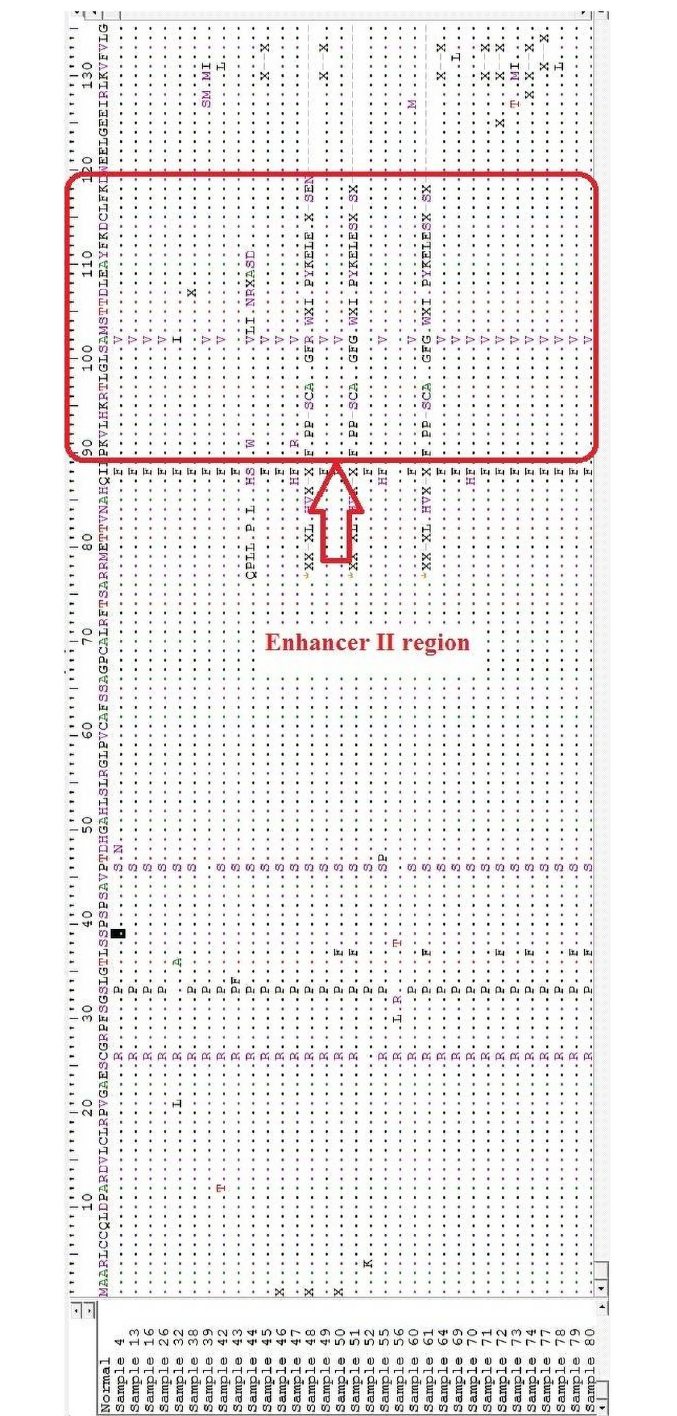
Fig 3. Comparison of the enhancer II region amino acid sequence with the reference sequence (Normal) showing amino acid substitutions and deletions.